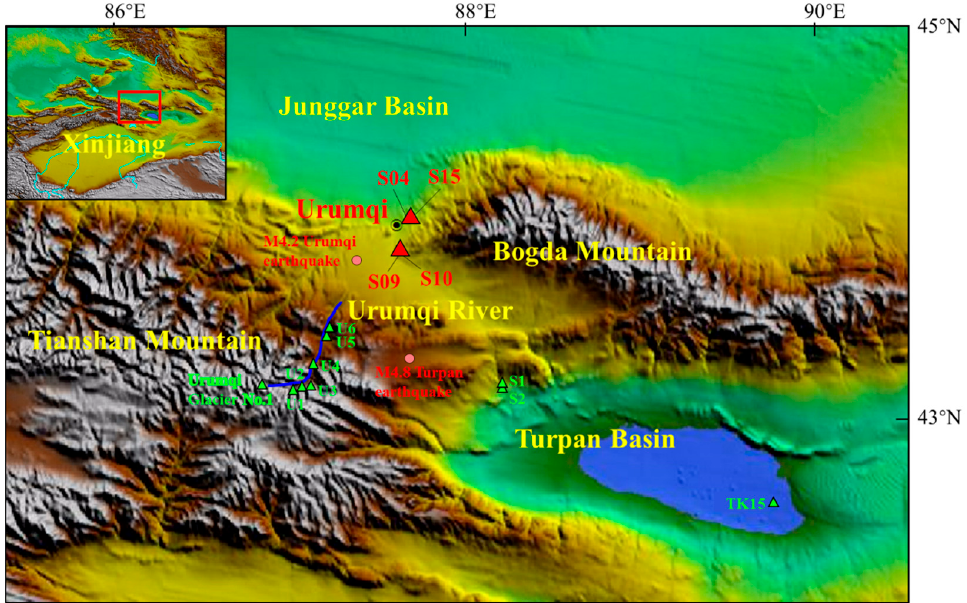
Figure 1. Topographical map of the study area. Red triangles show the locations of the springs analyzed in this study; green triangles show sample points from previous studies [34,35]; and pink circles show earthquakes. The inset map shows the wider regional setting with the red box delineating the study